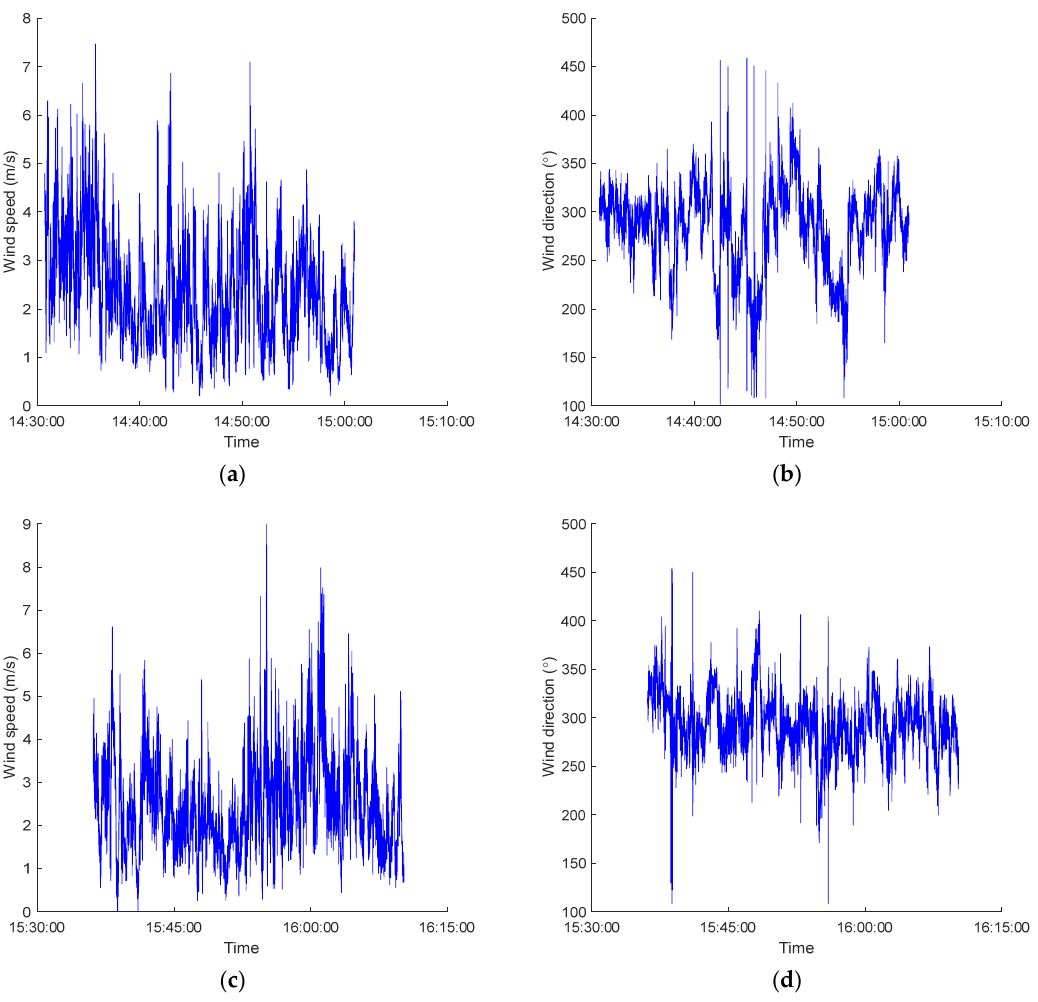
Figure 9. ( a , b ) Wind speed and wind direction for Release One period. ( c , d ) Wind speed and wind direction for Release Two period.